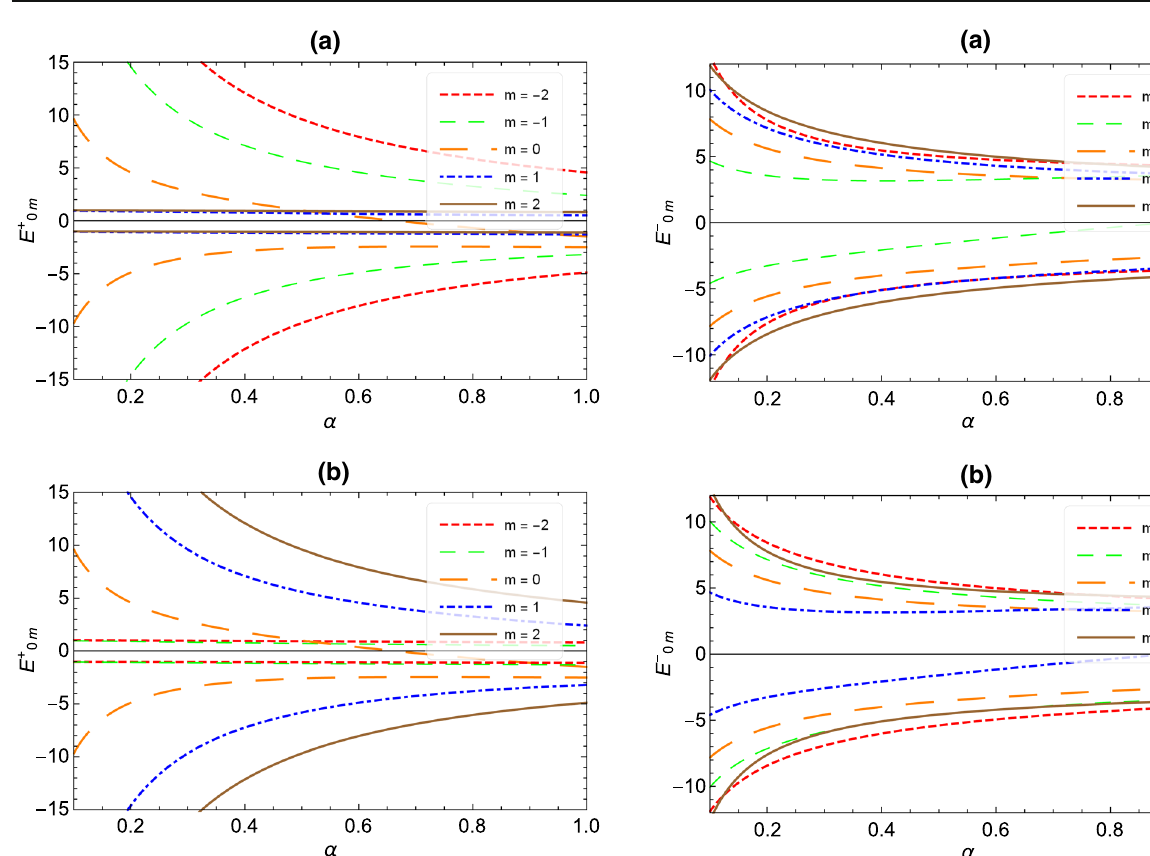
Fig. 2 Illustration of the energy eigenvalues in the pseudospin sym- metry limit, E − , as a function of the parameter α . In a the plot for 0 m s = 1 and b for s = − 1. We use M = 1, η C = 1 and η L = 1. The energies of the states corresponding to a given value of m near α = 0 in a and b are more energetic while near α = 1 the differences